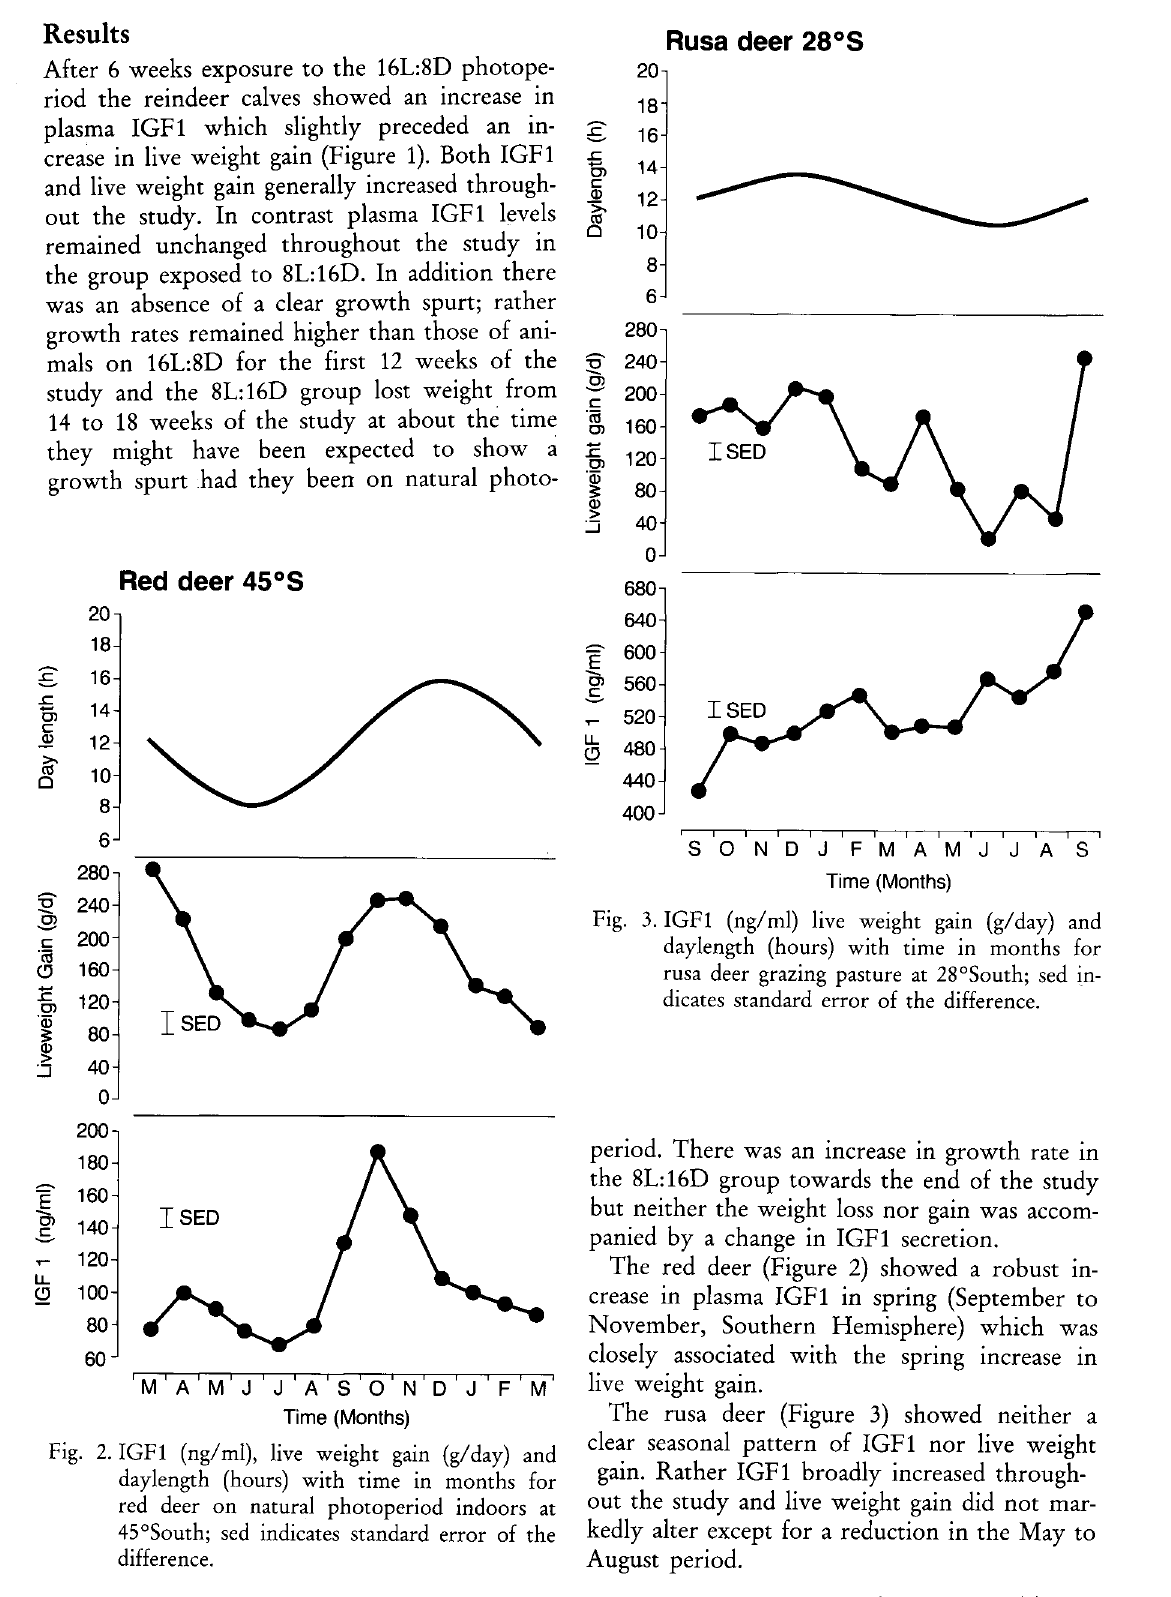
Fig. 2. IGF1 (ng/ml), live weight gain (g/day) and daylength (hours) with time in months for red deer on natural photoperiod indoors at 45°South; sed indicates standard error of the difference.